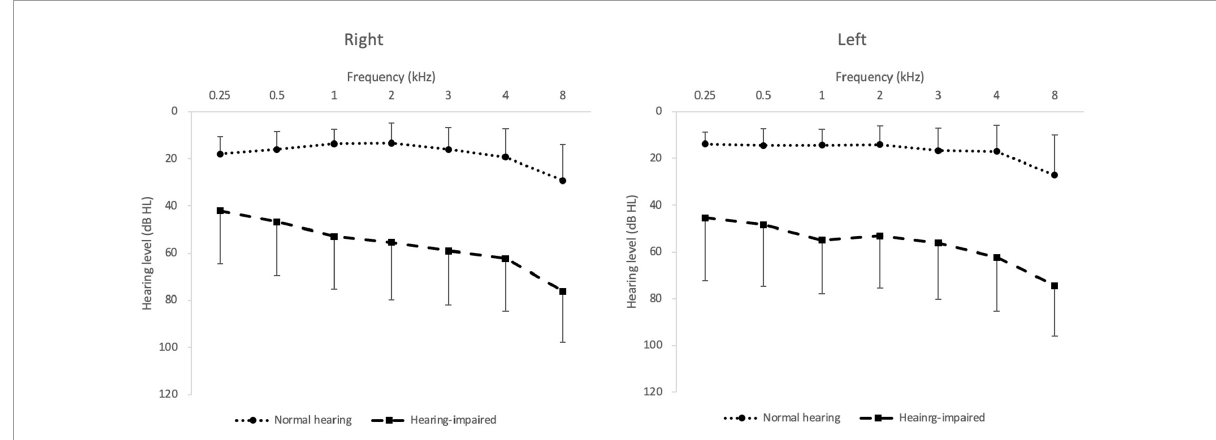
FIGURE1 Mean pure-tone hearing thresholds in the normal-hearing (filled circles) and hearing-impaired group (filled squares). The error bar indicates SD.